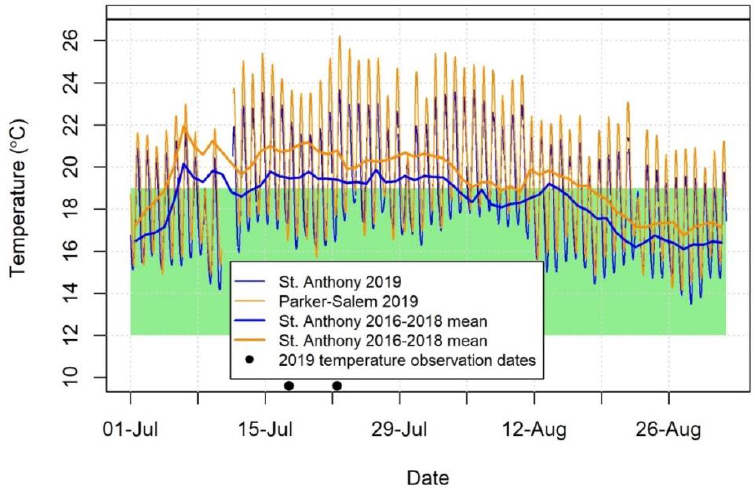
Figure A1. Streamflow at the St. Anthony gage (top of field study reach) and downstream of all diversions (roughly at the upstream extent of the springs identified in Figure 2).